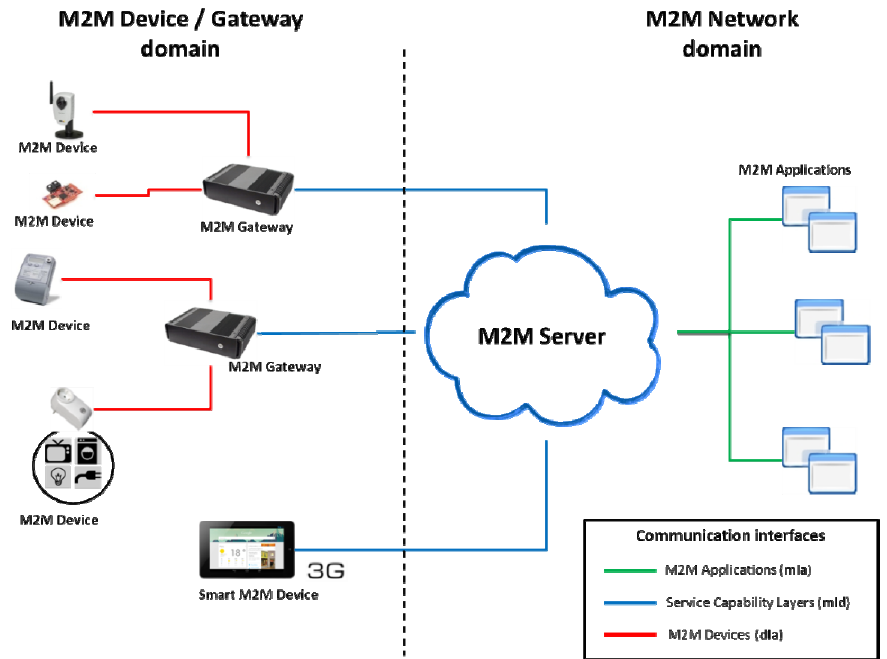
Figure 6. A view to ETSI M2M